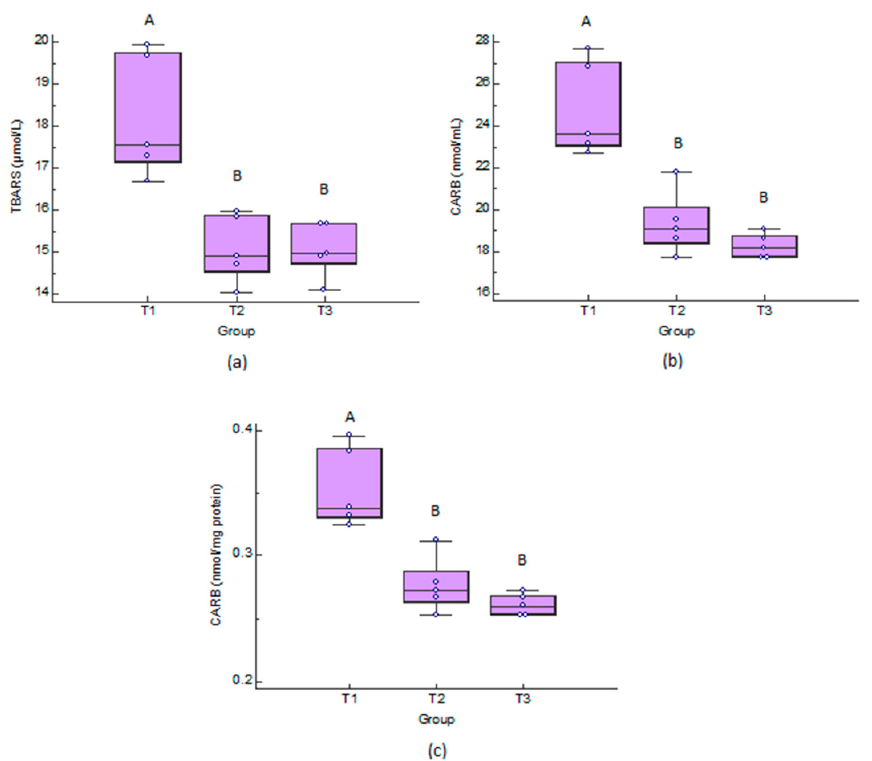
Figure 5. Dot and box and whisker plots of: ( a ) Thiobarbituric acid–reactive substances (TBARS); and ( b , c ) protein carbonyls (CARB) concentrations in control group (T1), group fed with Herb-All HEAT-A (T2) and group fed with Herb-All HEAT-D (T3). A,B Different letters above bars are indicative of significant difference ( p <